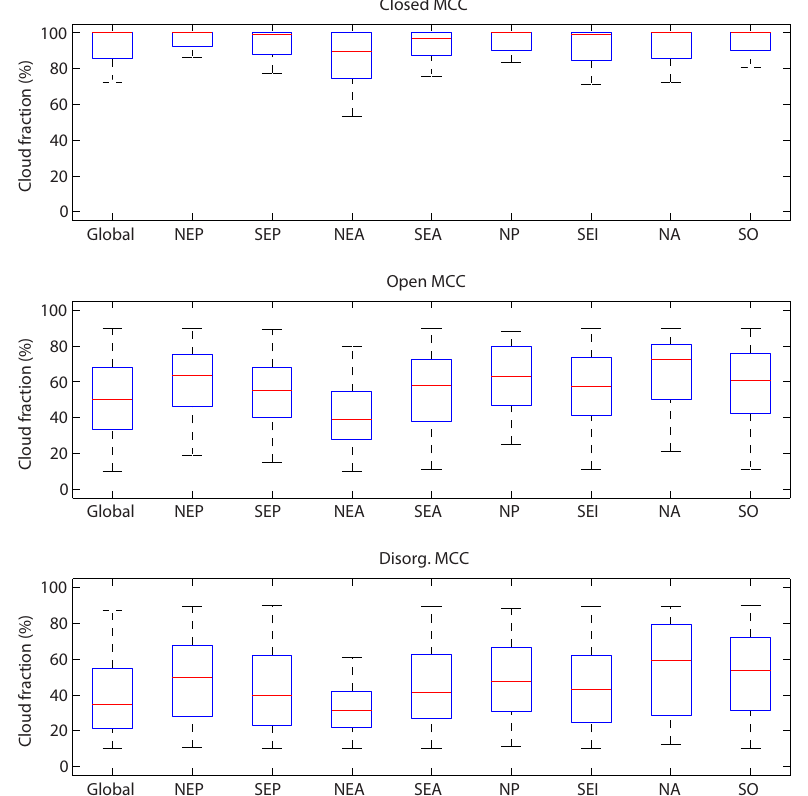
Figure 9. Box-and-whisker plots of cloud fraction for each MCC category. The median value is shown as a red horizontal line, boxes indicate the interquartile range (25th to 75th percentile) and the whiskers extend to ± 2 σ of the standard normal